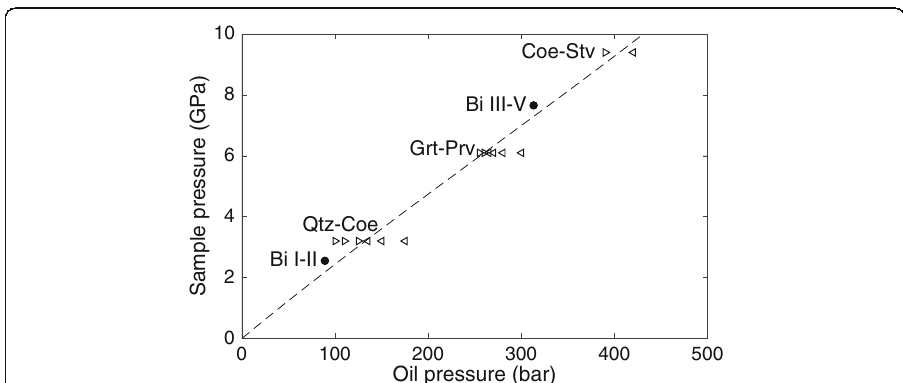
Fig. 7 The pressure calibration curve which relates the oil pressure in the oil vessel to the attained sample pressure for temperatures at room temperature (Bi) and at ~ 1300 °C. The dashed line is obtained from a spline interpolation through the high-temperature calibration